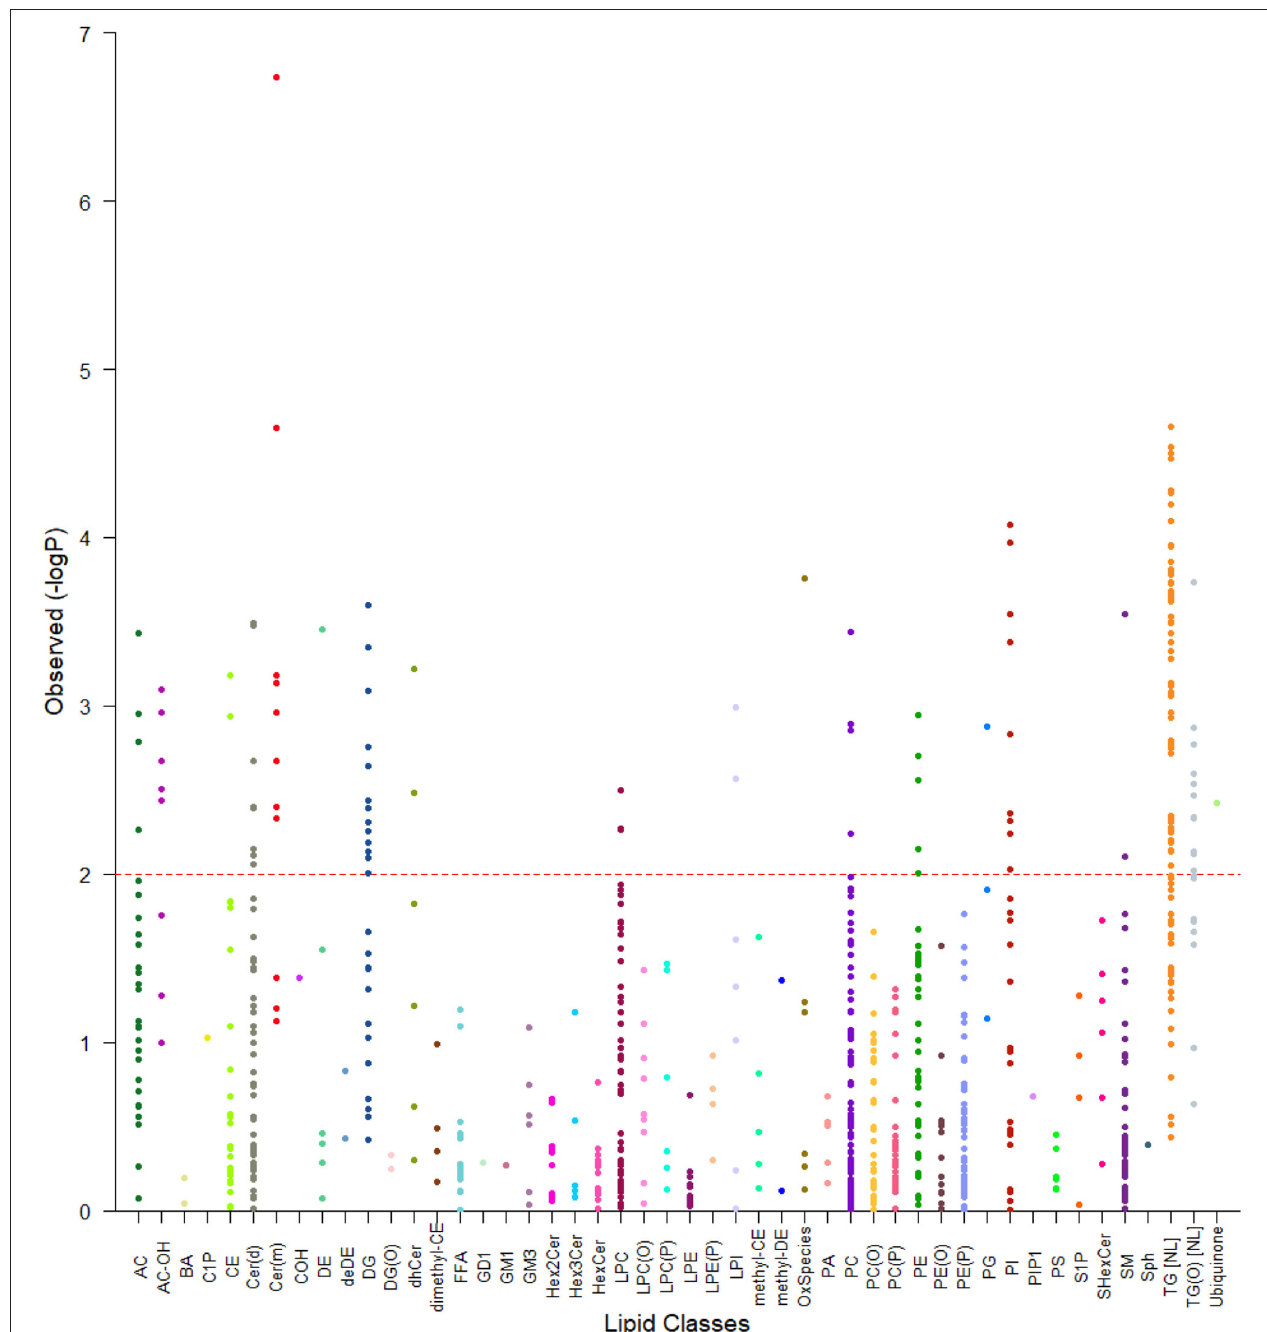
FIGURE 2 | Tornado plot of plasma lipidome associations with EAT volume. The figure shows all lipid species within their specific classes and the degree of association with EAT volume (FDR). Each dot represents a lipid species and each color a lipid class. The dotted line represents an FDR of 0.05. All species above the dotted line were considered as significantly associated with epicardial fat